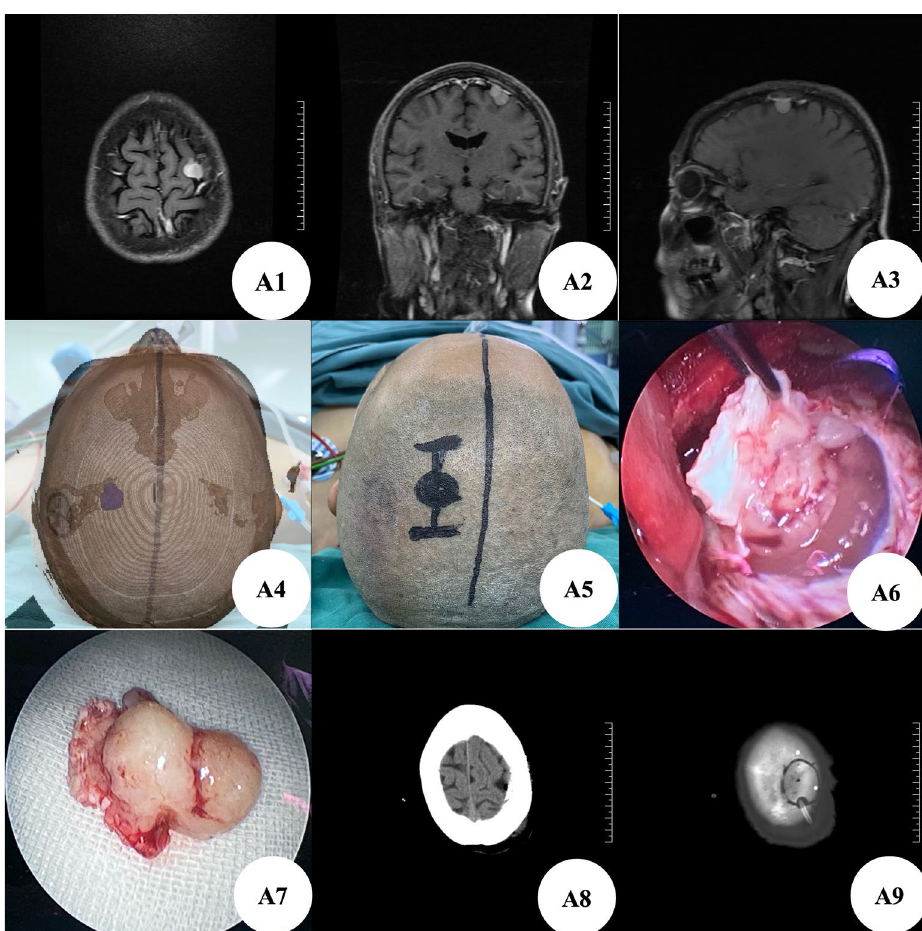
Figure 1. ( A1–A3 ) Brain MRI enhancement showed left frontal meningioma; ( A4 ) use the Apple mobile phone APP MosoCam for projection positioning; ( A5 ) the surgical incision was designed according to the projection location; ( A6 ) intraoperative neuroendoscopic brain tumor; ( A7 ) total tumor specimens; ( A8 ) postoperative brain CT showed that the tumor was resected cleanly without delayed bleeding; ( A9 ) brain CT showed the size of bone